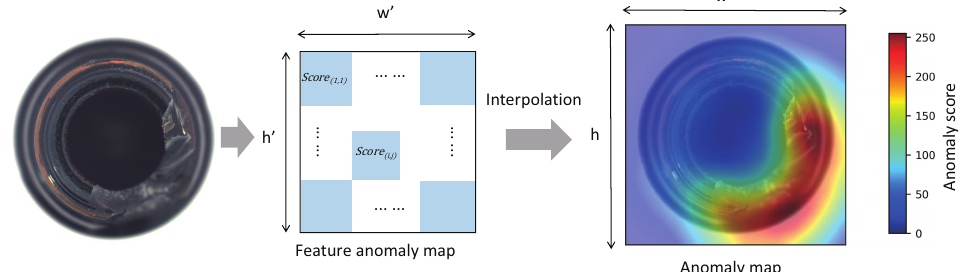
Figure 7. Using Mahalanobis distance as the anomaly score yields the feature anomaly map. The anomaly map is obtained by upsampling the feature anomaly